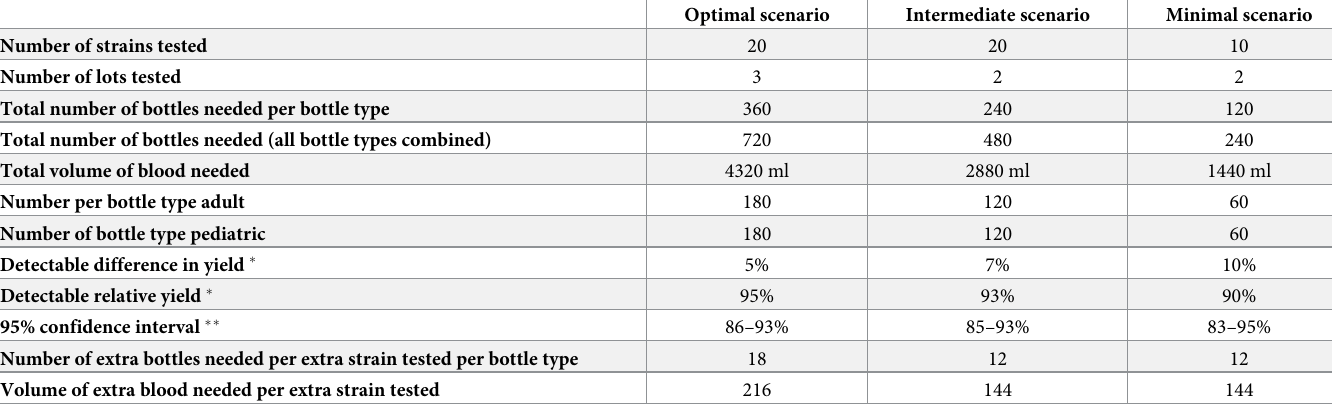
Table 3. Logistical and statistical implications of three scenarios of blood culture bottle (BCB) validation.